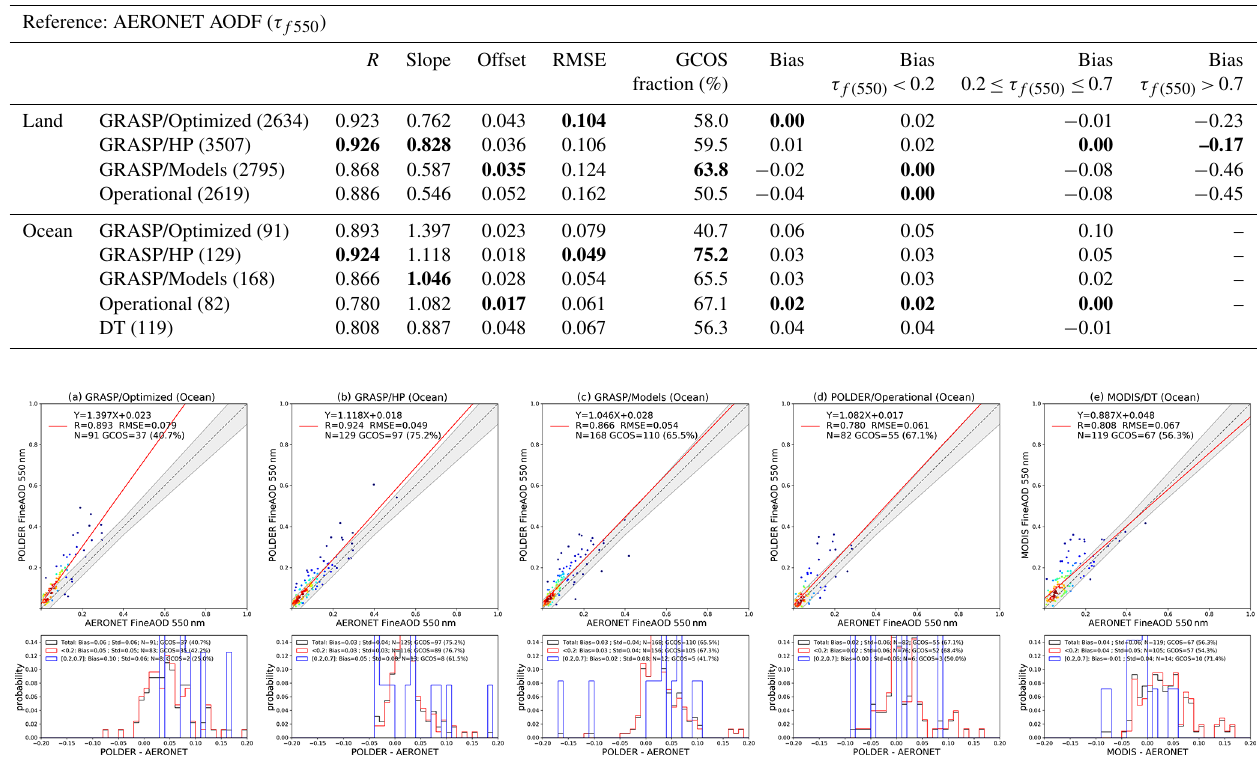
Figure 14. Validation of PARASOL/GRASP ( a GRASP/Optimized, b GRASP/HP and c GRASP/Models), (d) PARASOL/Operational and (e) MODIS/DT fine-mode AOD at 550nm over ocean in 2008. The gray envelope indicates GCOS requirement applied for AODF: max (0.04 or 0.1AODF). The probability density functions of differences (satellite–AERONET) are present in the lower panels. The black, red, blue and green solid lines indicate all AODF conditions: any AODF, AODF < 0.2, 0.2 ≤ AODF ≤ 0.7 and AODF > 0.7,